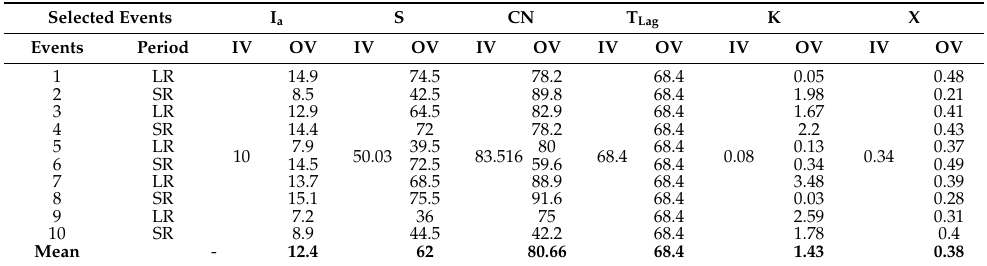
Table 5. Initial and optimized values for the parameters in the sensitivity analysis.